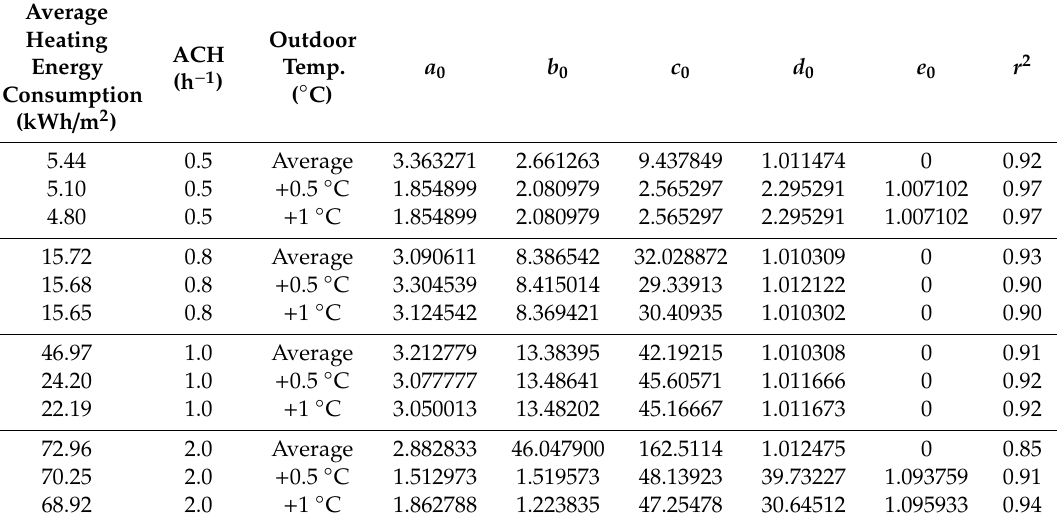
Table 1. Curve fitting of probability density function during the heating season.